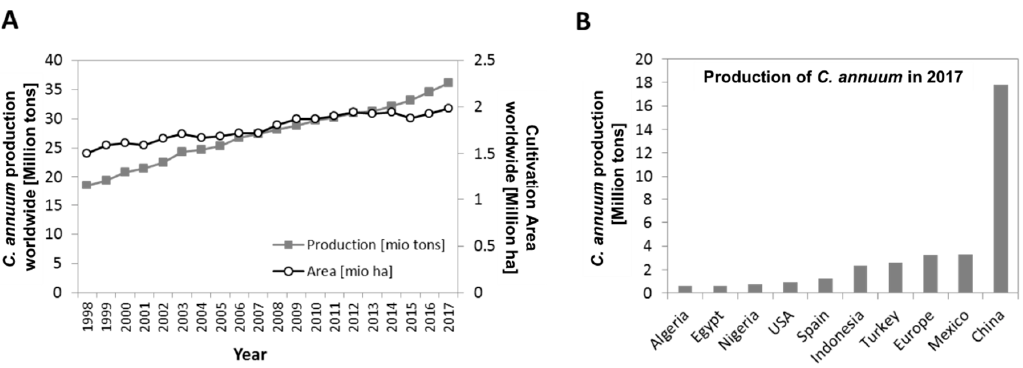
Figure 1. Capsicum annuum production statistics [35]. ( A ) Pepper production (grey line and squares, in million tons) and Cultivation Area (black line with white circles, in million ha) worldwide